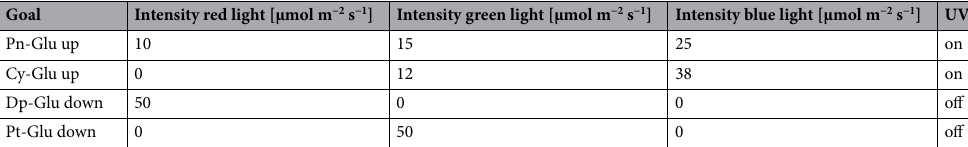
Table 4. Predicted light compositions to achieve the highest respectively lowest concentrations of four anthocyanins. Values and light compositions were calculated using the numerical optimization tool of the Design-Expert software and were compared to the source culture of the main experiment. Conc. = Concentration, Cy = Cyanidin, Dp = Delphinidin, Pn = Peonidin, Pt = Petunidin, Glu = Glucoside, Up = Upregulation (the goal is to maximize the concentration), Down = Downregulation (the goal is to minimize the